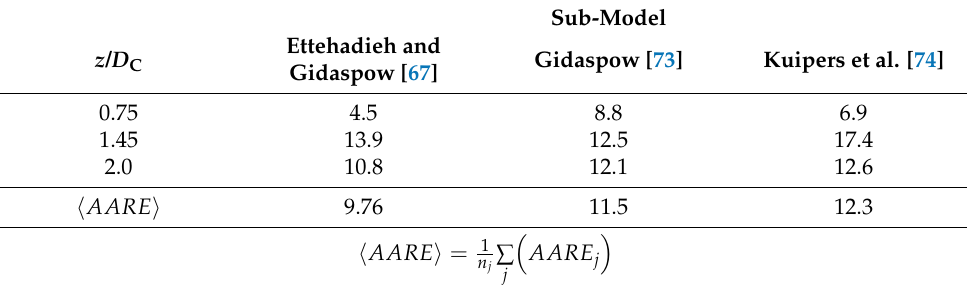
Table 4. Average Absolute Relative Error (%) in the time-averaged predicted radial solids holdup profiles for for a fluidized bed of D C = 14 cm, operating at modulus of elasticity